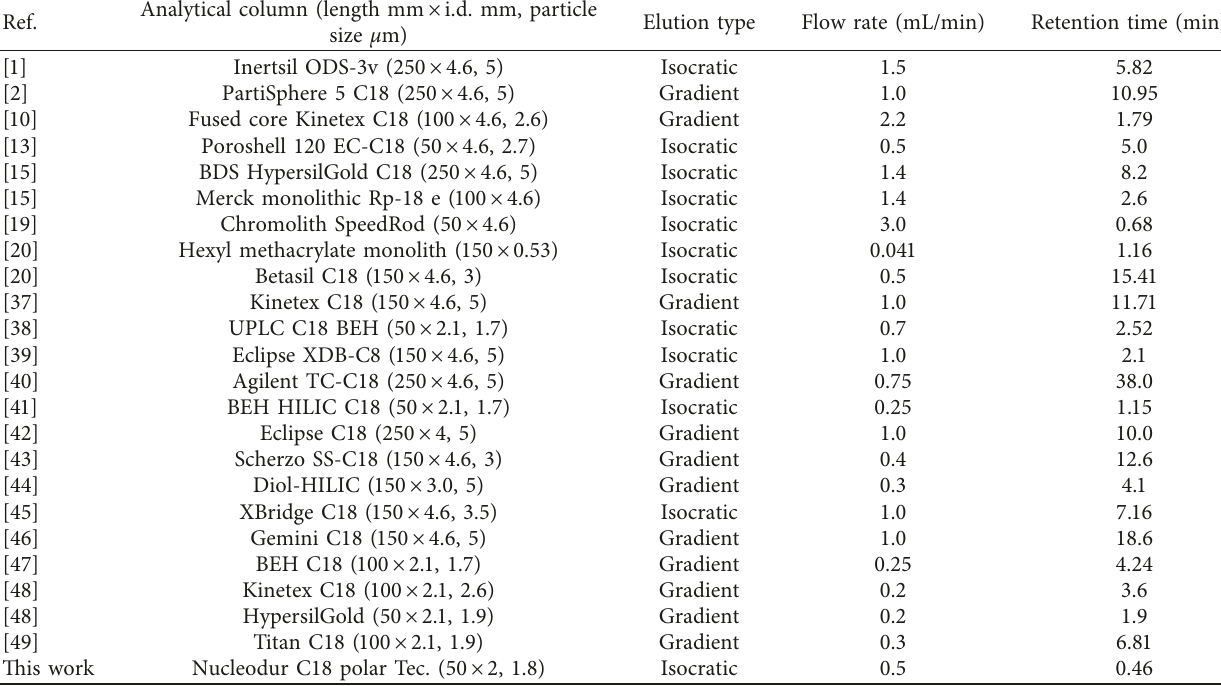
Table 3: Comparison of the proposed method with some of the recently reported HPLC methods for the determination of caffeine. Ref.